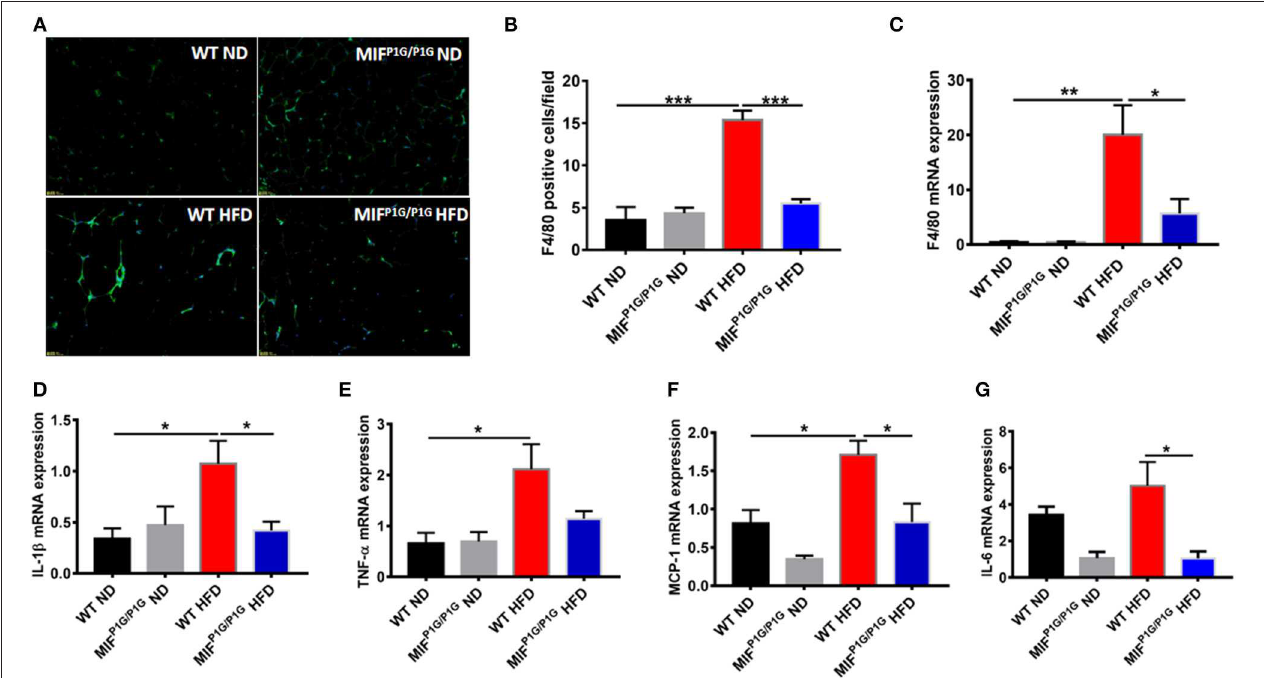
FIGURE 3 | MIF P1G / P1G mice reduced adipose tissue inflammation under HFD. (A) The expression of macrophage marker F4/80 in adipose tissue from the two group mice under ND or HFD was examined with immunofluorescence. (B) The quantification of the fluorescence image. (C) The expression of F4/80 by real-time PCR analysis in adipose tissue from the two group mice. (D–G) The expression of pro-inflammatory including IL-1 β , TNF α , MCP1, and IL-6 by real-time PCR analysis in adipose tissue from the two group mice. Data are shown as mean ± SEM, * p < 0.05, ** p < 0.01, and *** p < 0.001, n = 5–6 per group.